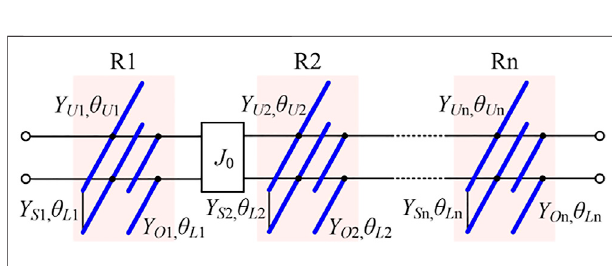
Figure 1A and replaces B i , the circuit model of dual-band with series dual-band resonators is therefore obtained in Figure 2 . All marked electric lengths are determined at f